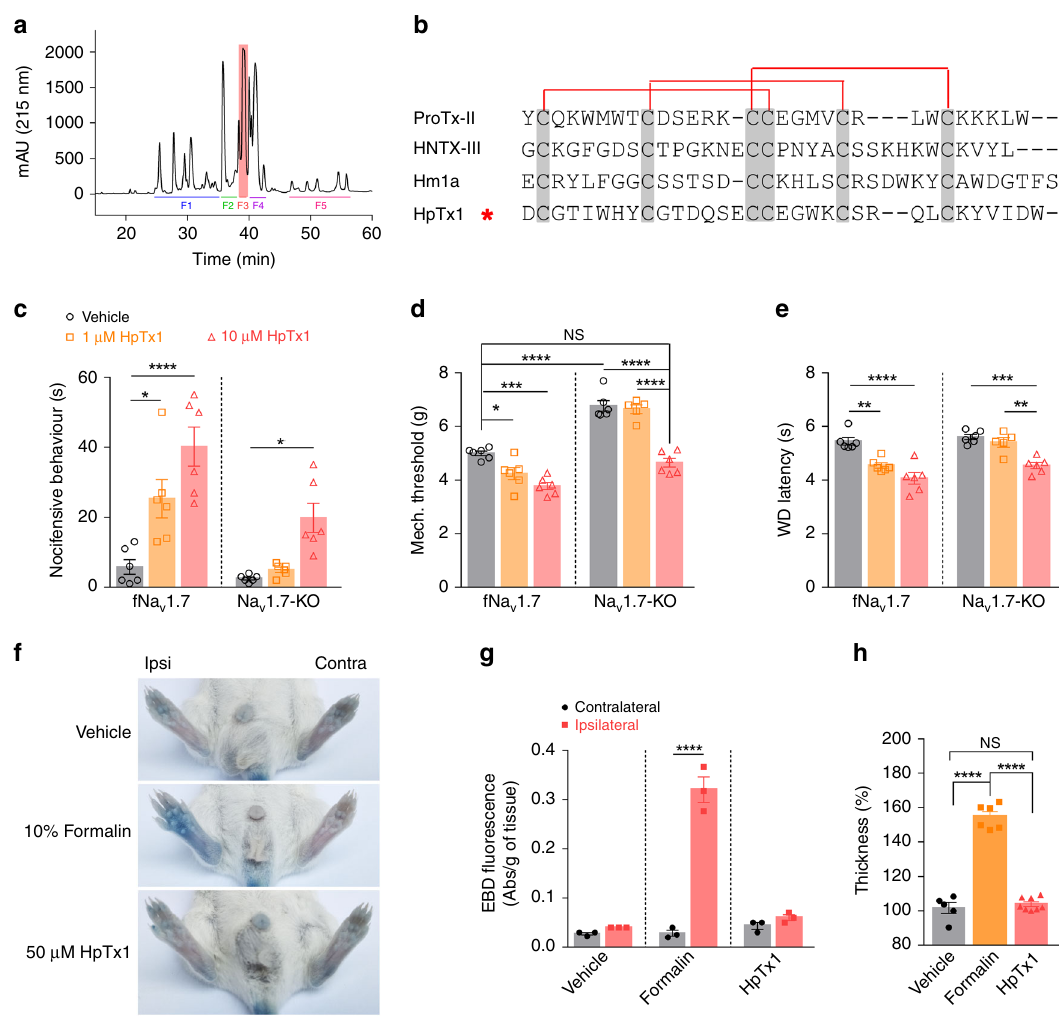
Fig. 1 HpTx1 rescues the pain response in Na v 1.7-KO mice. a RP-HPLC pro fi le of the venom from the spider H. venatoria . The F3 fraction contains HpTx1 (pink). b Sequence alignment of HpTx1 with several ICK toxins; red lines show the disul fi de linkage. c Comparison of nocifensive behaviors (licking or biting) following intraplantar injection of vehicle (10 μ l 0.9% saline, n = 6) versus HpTx1 (1 μ M or 10 μ M in 10 μ l saline, n = 6) (two-way ANOVA followed by Tukey ’ s multiple comparisons test, treatment × genotype: F (2,30) = 3.447, P = 0.0449; treatment: F (2,30) = 24.05, P < 0.0001; genotype: F (1,30) = 23.09, P < 0.0001). d Mechanical response thresholds measured in paws in response to vehicle (black circles, n = 6), 1 μ M HpTx1 (yellow squares, n = 6 for fNa v 1.7 mice; n = 5 for Na v 1.7-KO mice) or 10 μ M HpTx1 (red triangles, n = 6) injections (two-way ANOVA followed by Tukey ’ s multiple comparisons test, treatment × genotype: F (2,29) = 10.52, P = 0.0004; treatment: F (2,29) = 54.72, P < 0.0001; genotype: F (1,29) = 150.2, P < 0.0001). e Latency of